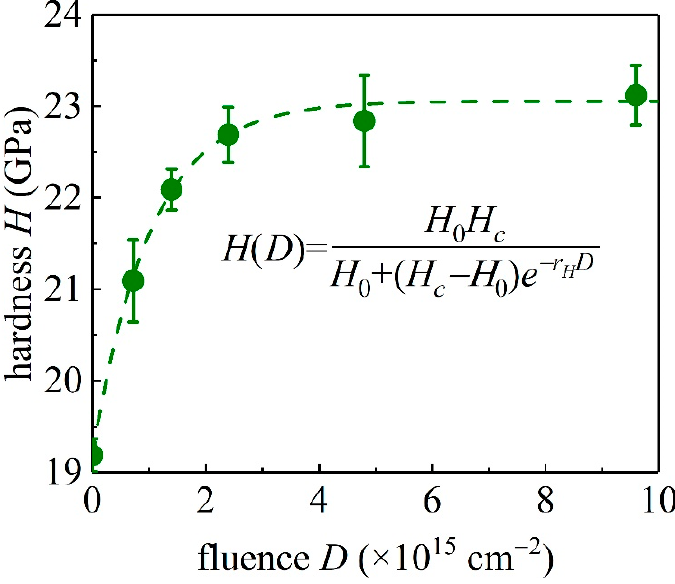
Figure 7. The hardness H of GaN single crystal samples as a function of ion fluence D .